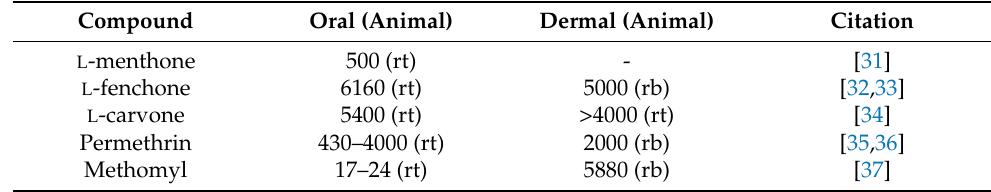
Table 4. Oral and dermal LD 50 values for L -menthone, L -fenchone, and L -carvone compared to permethrin and methomyl in rats and